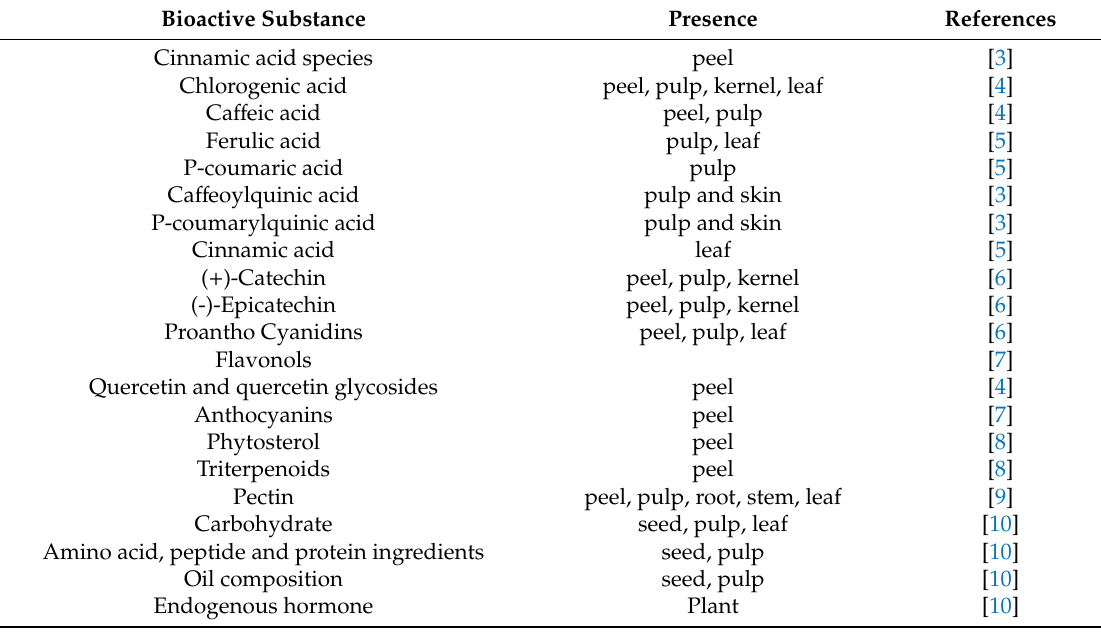
Table 1. The distribution of bioactive substances in